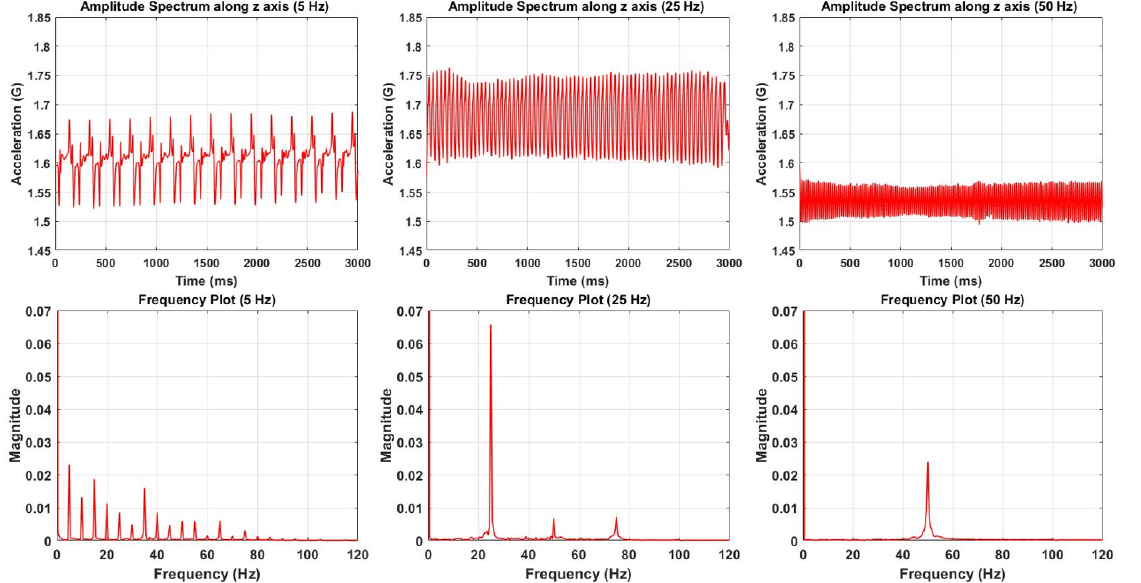
Figure 8. Examples of rendered vibration feedback in the time and single-sided frequency